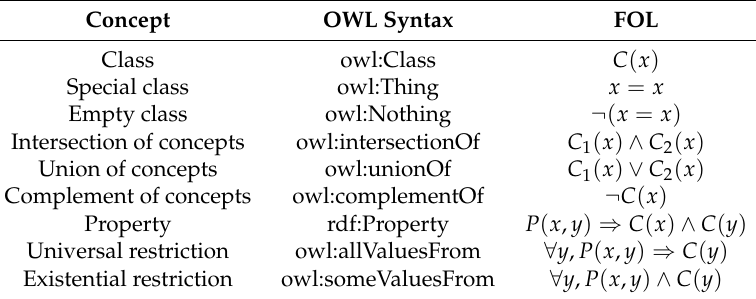
Table 1. Translation of OWL concepts into first-order logic